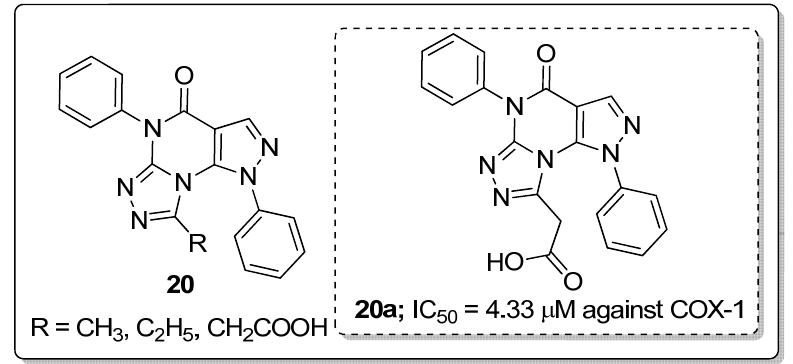
Figure 24. Anti-inflammatory activity of the most active pyrazole fused triazole hybrid 20a Figure 24. Anti ‐ inflammatory activity of the most active pyrazole fused triazole hybrid 20a .